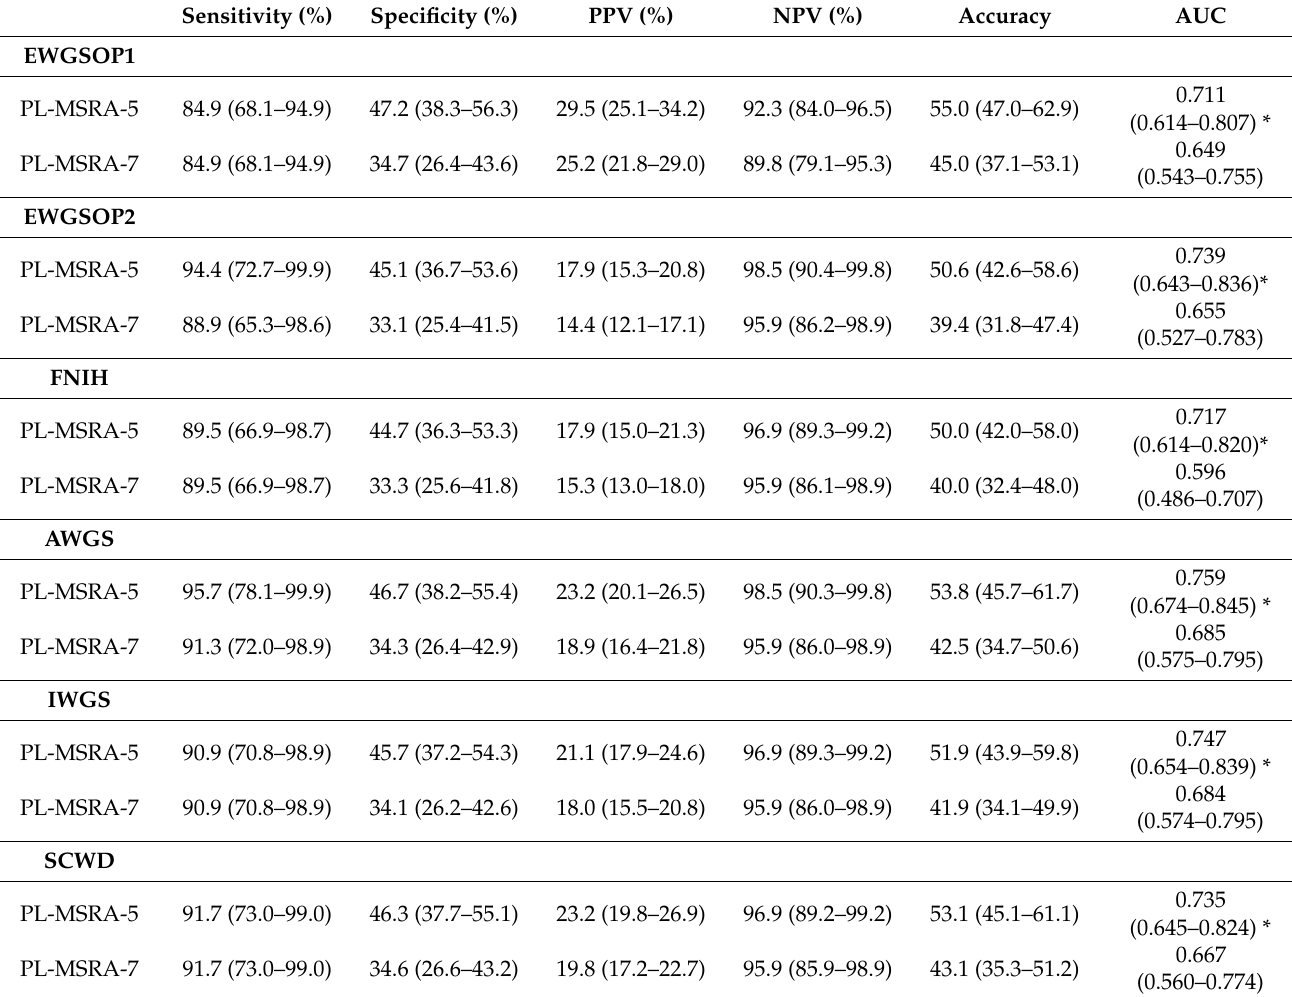
Table 6. Sensitivity, specificity, positive and negative predictive values and receiver operating curve model of the PL- MSRA-5 and PL-MSRA-7 questionnaires against six sets of international diagnostic criteria of sarcopenia in the whole study